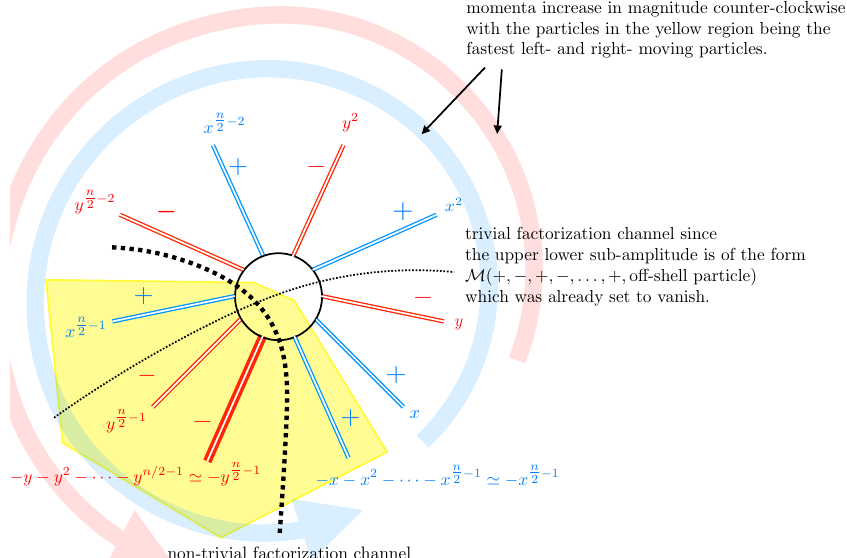
Figure 5 . Non-vanishing factorizations have p 1 and p n on di(cid:11)erent sides of the propagator. Or- ganizing the contributions by the vertex including p 1 (see (cid:12)gure 6) we see that all of them are proportional to full amplitudes. Hence, only the one with an ( n 2)-particle vertex on one side and (cid:0) the 4-particle amplitude on the other